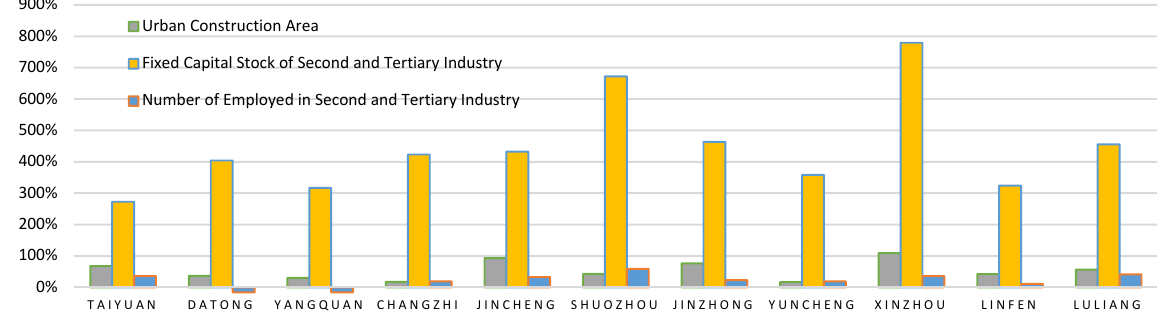
Figure 1. The percentage increase of input variables (i.e., urban construction area, the fixed capital stock of secondary and tertiary industry, and the number of people employed in the secondary and tertiary industries from 2006 to 2015).